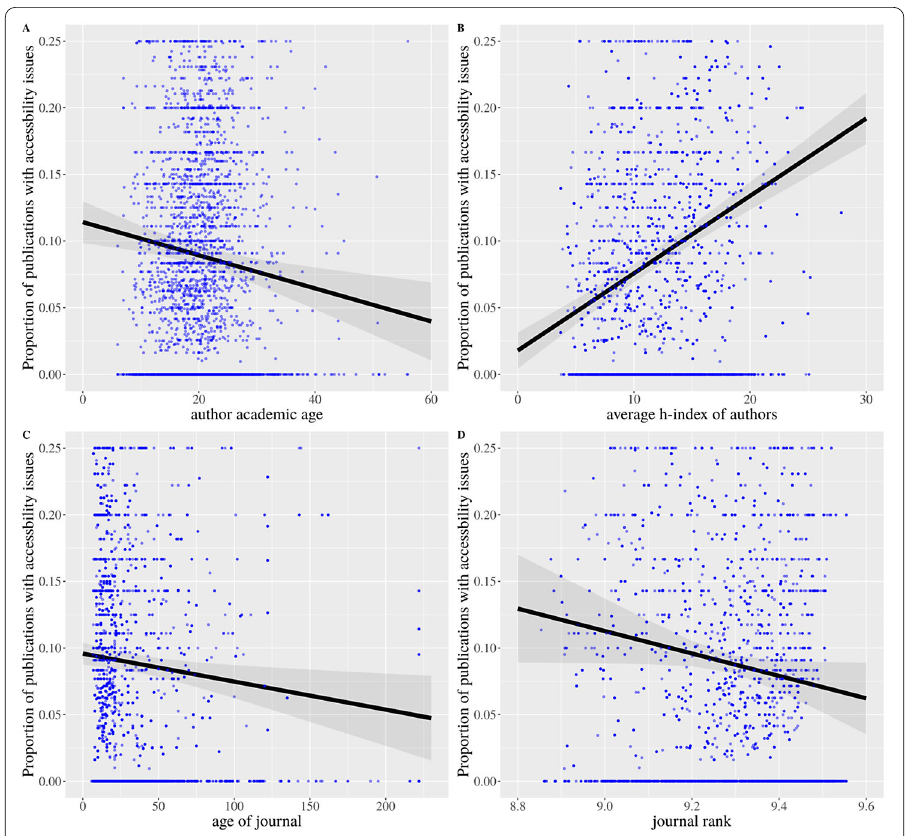
Figure 5 Statistically significant marginal effects on journals’ proportion of publications with accessibility issues. ( A ) journal average author academic age’s marginal effect ( B ) journal average author h-index’s marginal effect ( C ) journal age’s marginal effect ( D ) journal rank’s marginal